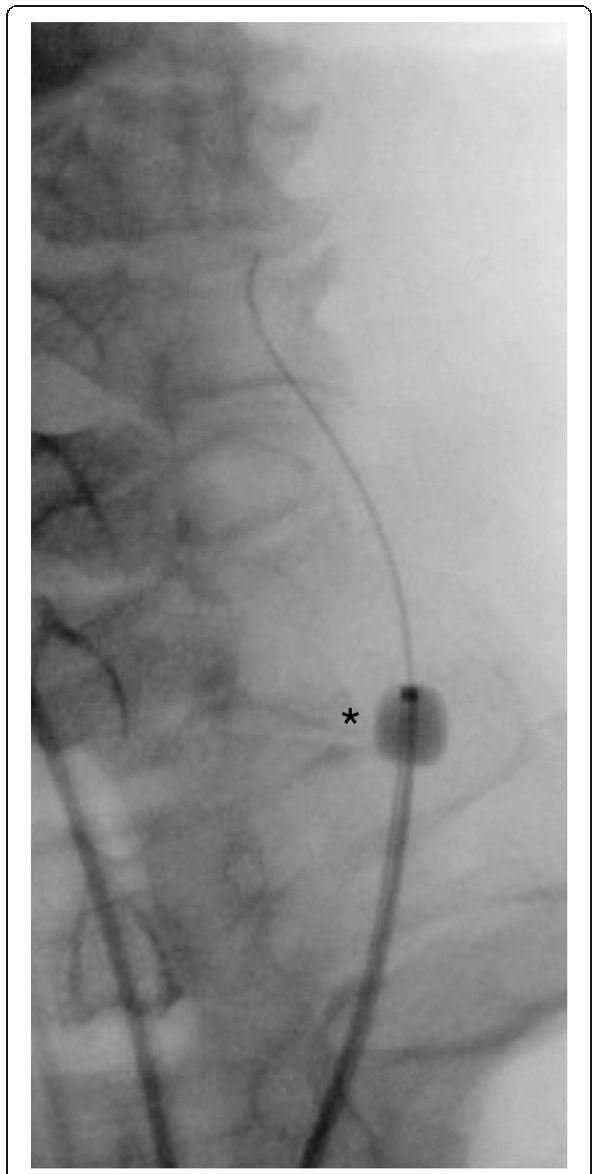
Fig. 5 Balloon occlusion of the CCA puncture site with a Corail occlusion balloon catheter